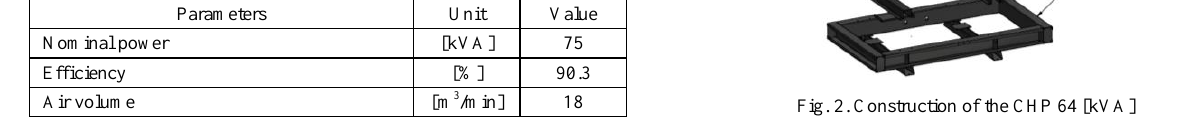
Table 2. Linz Electric PRO22S B/4 parameters